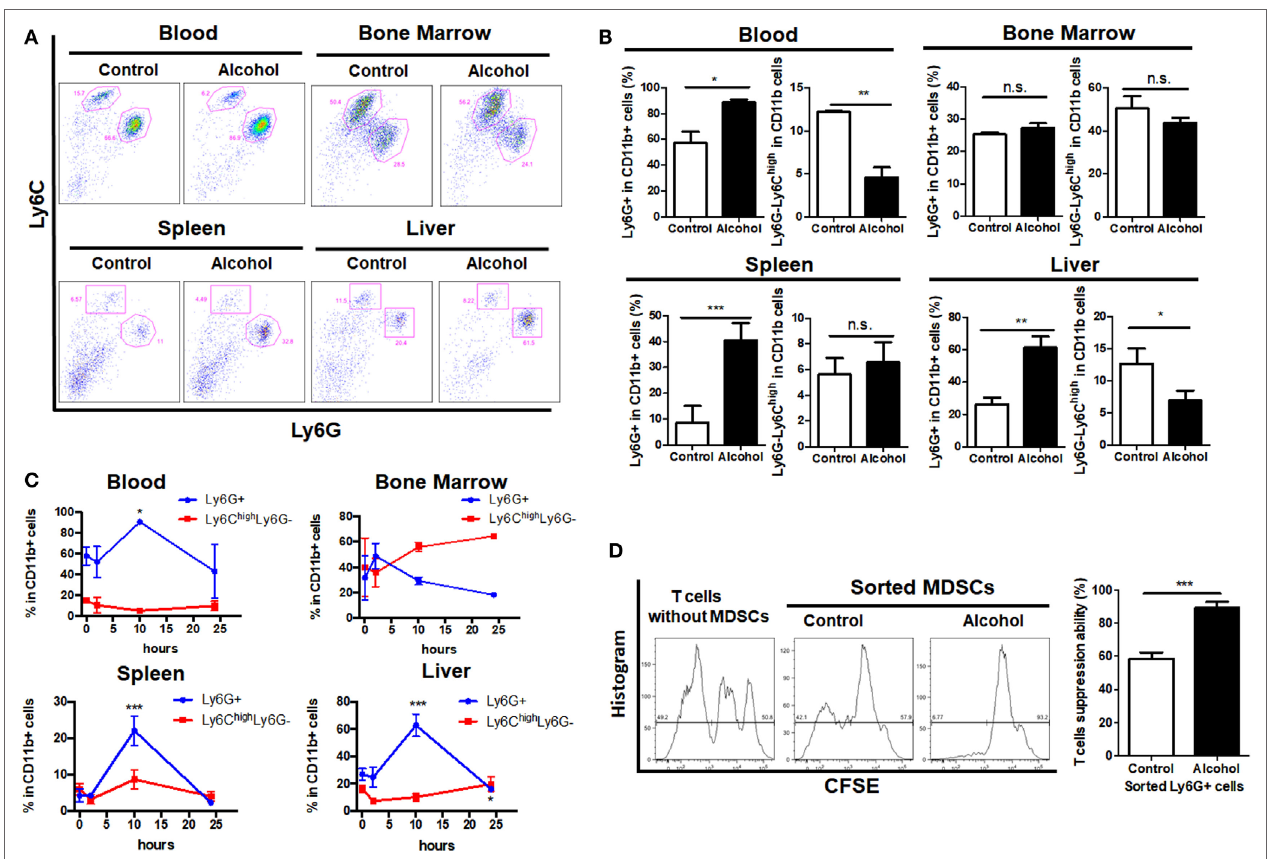
FigUre 1 | Profile of myeloid-derived suppressor cells (MDSCs) populations in mice treated with vehicle or ethanol. Mice were divided into two groups, ethanol group ( n = 6) treated with a single dose of ethanol (6 g/kg body weight) via gavage and control group ( n = 6) received isocaloric dextrin-maltose. After 10 h, mice were sacrificed and cells were obtained from blood, liver, spleen, and bone marrow for flow cytometric analyses. (a) Representative images and (B) quantification of flow cytometric analyses of cells from blood, spleen, liver, and bone marrow of mice with vehicle or ethanol treatment. Then time frame of MDSCs in response to ethanol treatment was elaborated. Mice were sacrificed at 2 h ( n = 6), 10 h ( n = 6), and 24 h ( n = 6) after the ethanol treatment, and populations of granulocytic- MDSCs (G-MDSCs) and monocytic-MDSCs (M-MDSCs) were determined by flow cytometer. (c) Time course of G-MDSCs and M-MDSCs in tissues after ethanol exposure. Change of the MDSCs population was normalized within 24 h after a single dose of ethanol. G-MDSCs were sorted from mice treated with vehicle or ethanol by FACS Aria I cytometer (BD) and co-cultured with carboxyfluorescein succinimidyl ester (CFSE)-labeled cytotoxic T cells sorted from spleen of naïve mice. (D) Representative histogram images of flow cytometric and quantification analyses of CFSE intensity in CFSE-labeled T cells co-cultured with G-MDSCs cells treated with ethanol or vehicle. Data were analyzed as mean value ± SD and Student’s T -test was used to assess the result significance. * p < 0.05, ** p < 0.01, *** p < 0.001, compared with the control group; n.s., not